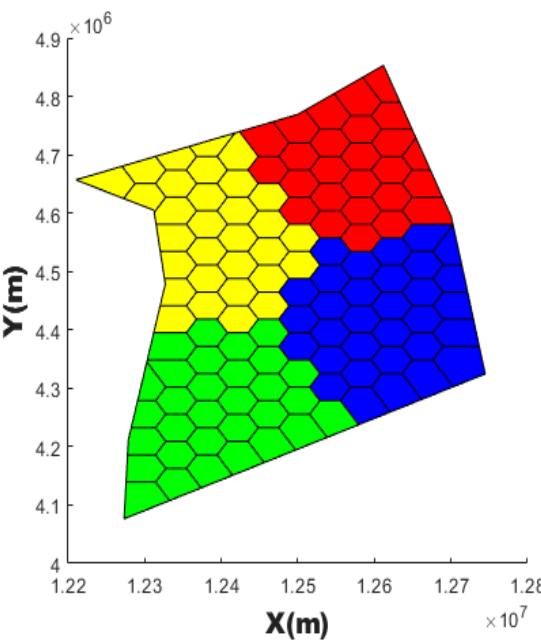
Figure 6. Voronoi cells are reconstructed and colored according to the airspace boundary.